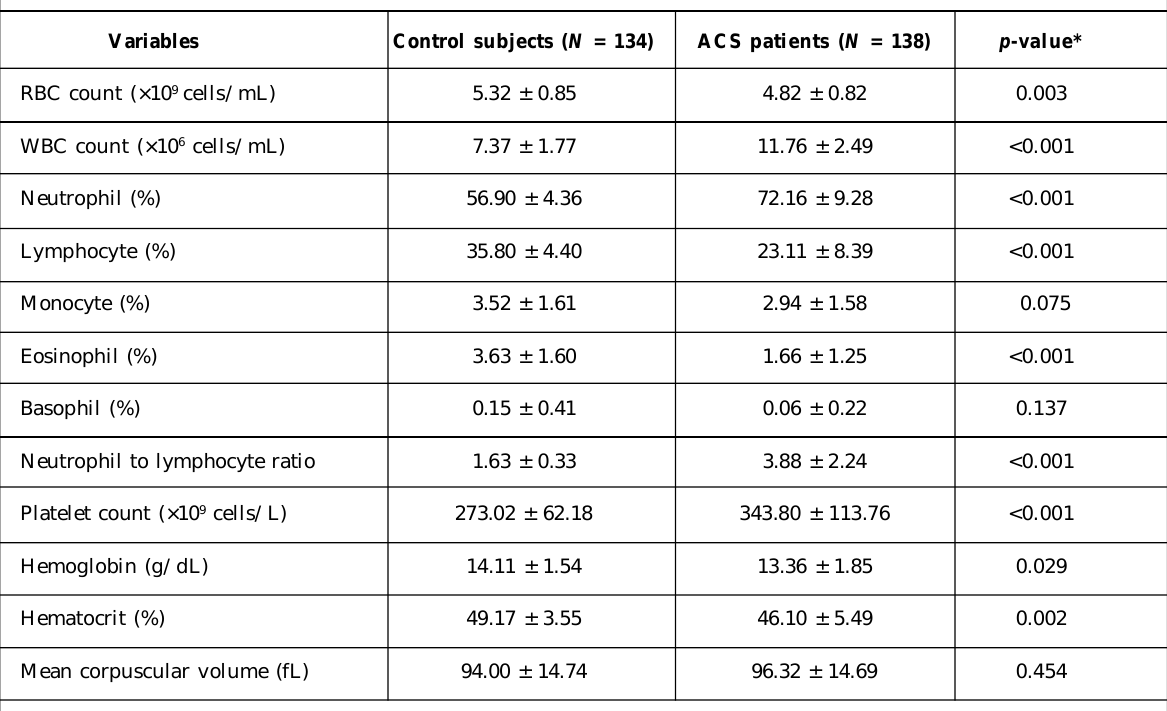
Table 2: Comparison of complete blood count of the control subjects and ACS patients Variables